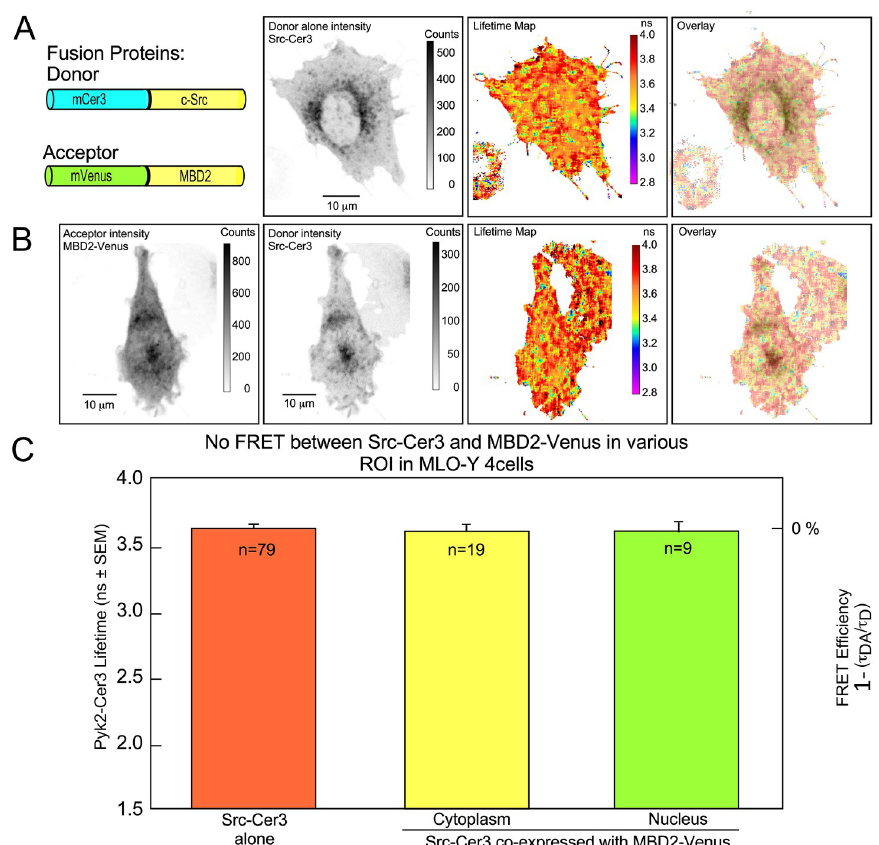
Fig 4. FRET was not detected between Src-Cer3 and MBD2-Venus in MLO-Y4 cells. Panel A shows (from left to right) diagrams of the Donor (Src-Cer3) and Acceptor (MBD2-Venus) constructs (left side), and the distribution intensity of Src-Cer3 donor expressed alone, the Lifetime map of the Src-Cer3 donor alone and the IMD overlay of the Lifetime map and donor intensity. Of note, the Lifetime map and IMD overlay in panel A demonstrates the uniform lifetime (average of 3.61 ns) throughout the cell transfected with Src-Cer3 donor alone. Panel B shows (from left to right) cells co-transfected with MBD2-Venus (Acceptor), Src-Cer3 (Donor), the Lifetime map of Src-Cer3 in the presence of MBD2-Venus, and the IMD overlay of the Lifetime map and donor intensity. Of note, no cooler colors (blues and purples) are seen indicating that FRET is not occurring between Src-Cer3 and MBD2-Venus. Panel C shows quantification of the Src-Cer3 Lifetimes (on the left y-axis) when Src-Cer3 was expressed alone (orange bar), and in 2 regions of interest (ROI) from cells co-transfected with Src-Cer3 and MBD2-Venus (cytoplasm and nucleus). FRET efficiency is zero throughout the cell, regardless of differences in the sub-cellular concentration of each protein (calculated as 1 minus the ratio of lifetime of the donor/acceptor ( τ DA ) to the donor alone ( τ D ) and indicated on the right